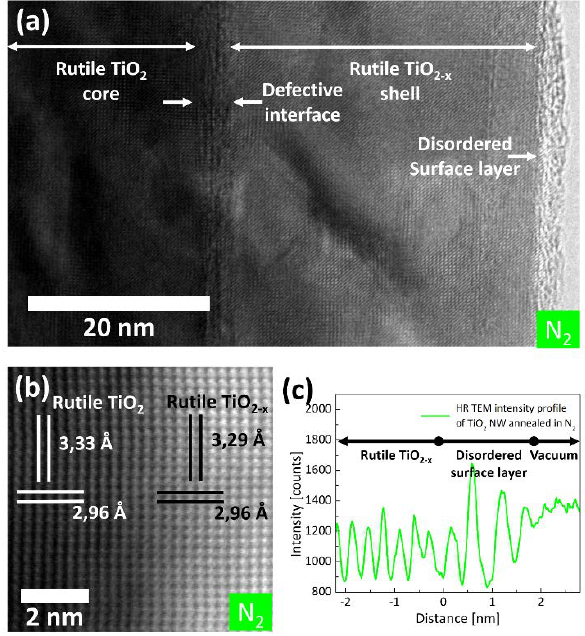
Figure 4. ( a ) High resolution (HR) transmission electron microscopy (TEM) image of a NW annealed in N 2 showing the surface near region. ( b ) Annular bright field STEM image of the interface between the rutile TiO 2 core and the TiO 2− x shell. ( c ) Intensity line scan of ( a ) showing an out-of-plane periodicity in the disordered surface layer parallel to the [001] growth direction.